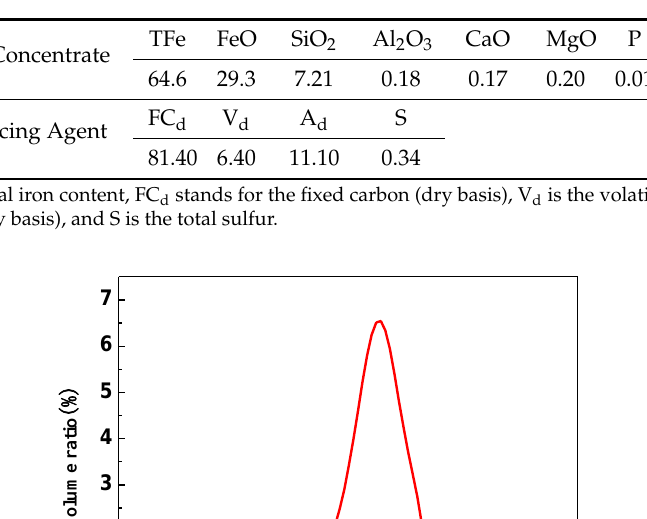
Table 1. Chemical composition of the raw materials (wt %).